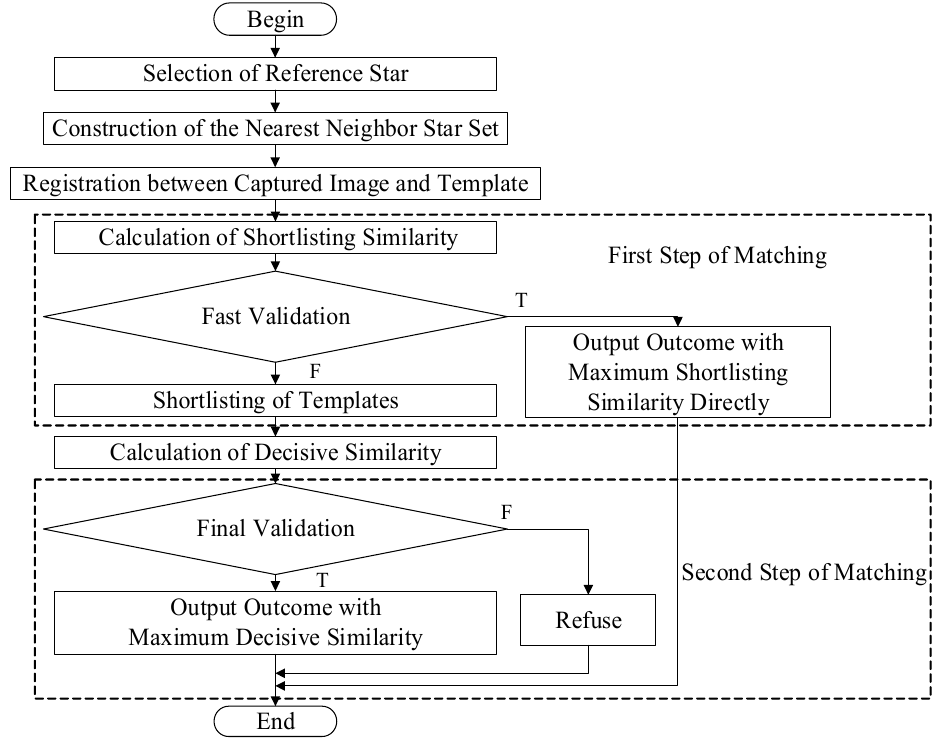
Figure 9. Schematic overview of the proposed algorithm.